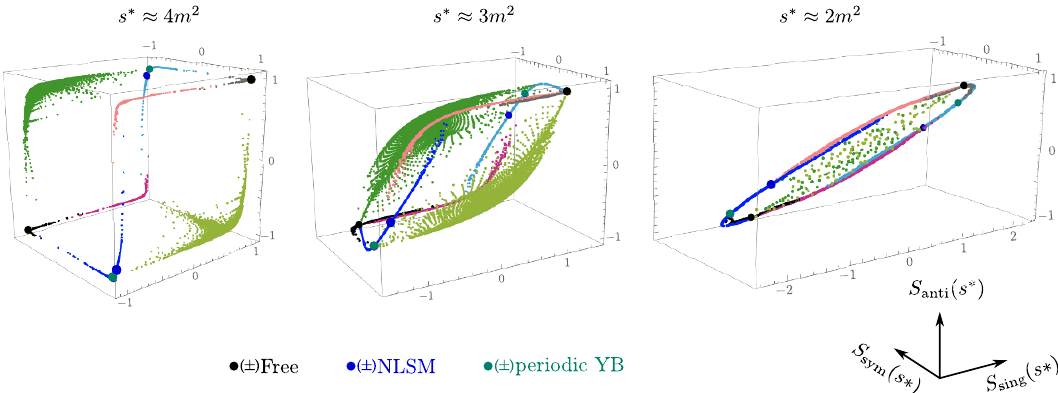
Figure 6 . Space of allowed S-matrices S a ( s (cid:3) ) for N = 7 and di(cid:11)erent values of s (cid:3) , obtained using functionals of the normal type. Close to threshold s (cid:3) (cid:25) 4 m 2 the space approaches the cube de(cid:12)ned by unitarity j S a ( s ) j (cid:20) 1 for physical values s > 4 m 2 . As we decrease s (cid:3) , the monolith morphs into the two-dimensional slate at s (cid:3) = 2 m 2 . At the boundary of the allowed space we have the 3 (+ 3 (cid:13)ipping all signs) integrable solutions, namely free theory, the NLSM [13] and the periodic Yang-Baxter solution [5]. The coloring corresponds to the associated S a ( s = 4 m 2 ) values as in table 1 of appendix